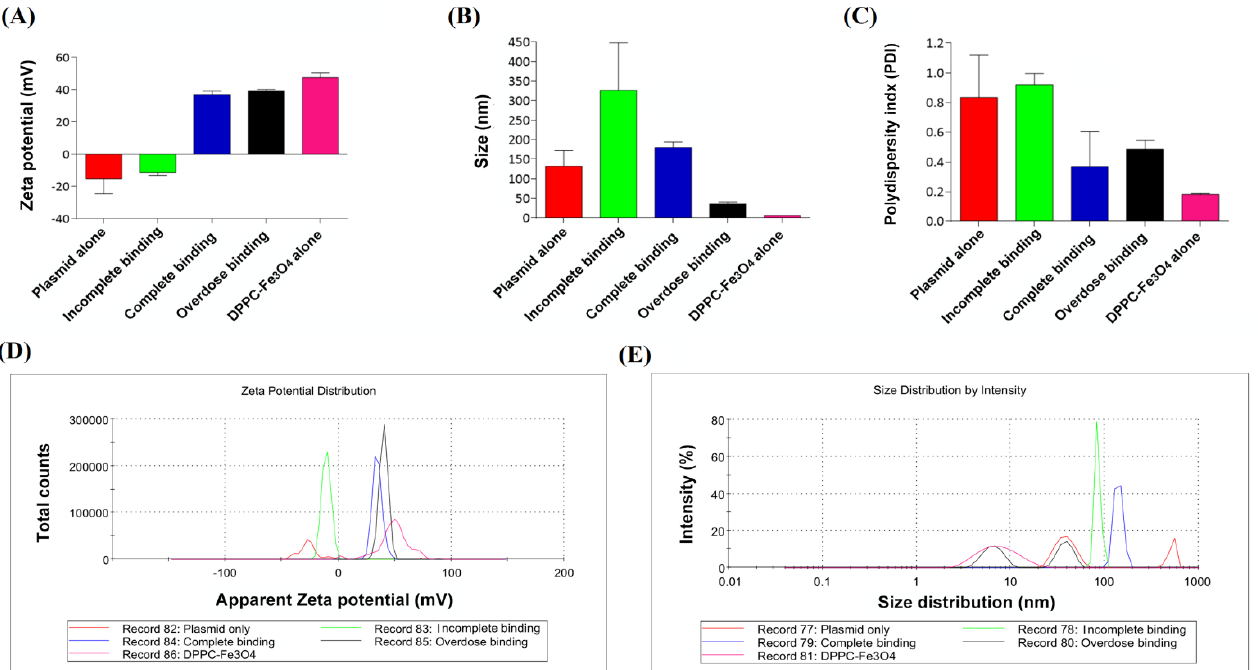
Figure 3. DLS analysis of nanoparticle characteristics in different dosages of DPPC-Fe 3 O 4 binding with a constant amount of circular form plasmid DNA. ( A ) Average zeta potential (mV), ( B ) average size (nm), ( C ) polydispersity index (PDI) value, ( D ) profile of zeta potential distribution, and ( E ) profile of size distribution in different groups of circular plasmid DNA alone, DPPC-Fe 3 O 4 alone, DPPC-Fe 3 O 4 -plasmid incomplete binding (200 ng DPPC-Fe 3 O 4 : 1000 ng circular DNA = 0.2:1.0; w / w ), Fe 3 O 4 -plasmid complete binding (1000 ng DPPC-Fe 3 O 4 : 1000 ng circular DNA = 1.0:1.0; w / w ), and Fe 3 O 4 -plasmid overdose binding (4000 ng DPPC-Fe 3 O 4 : 1000 ng circular DNA = 4.0:1.0; w / w ). Data are presented as the mean ± SD (n = 3).